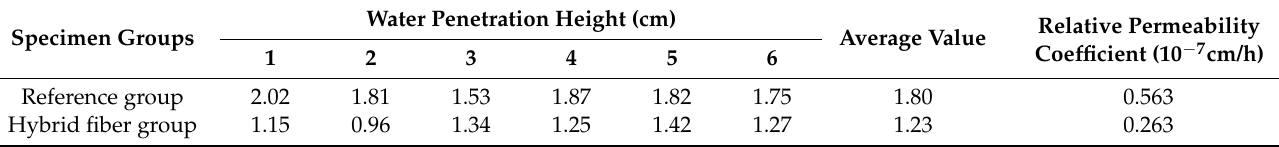
Table 8. Concrete impermeability test